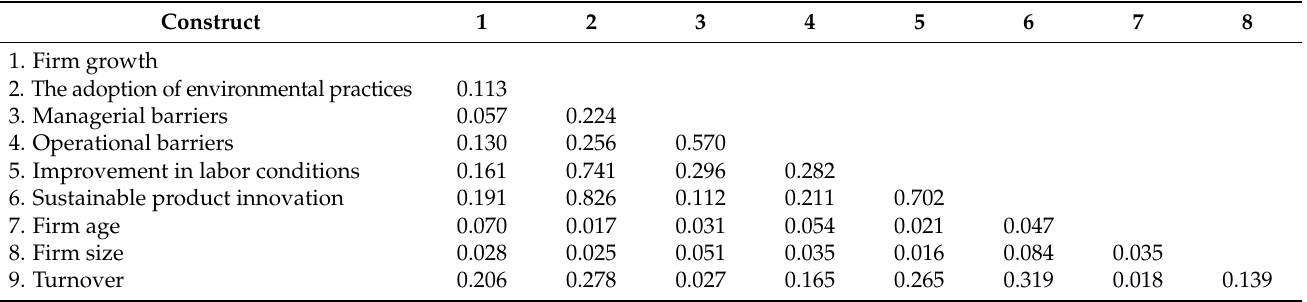
Table 3. Heterotrait–monotrait ratio